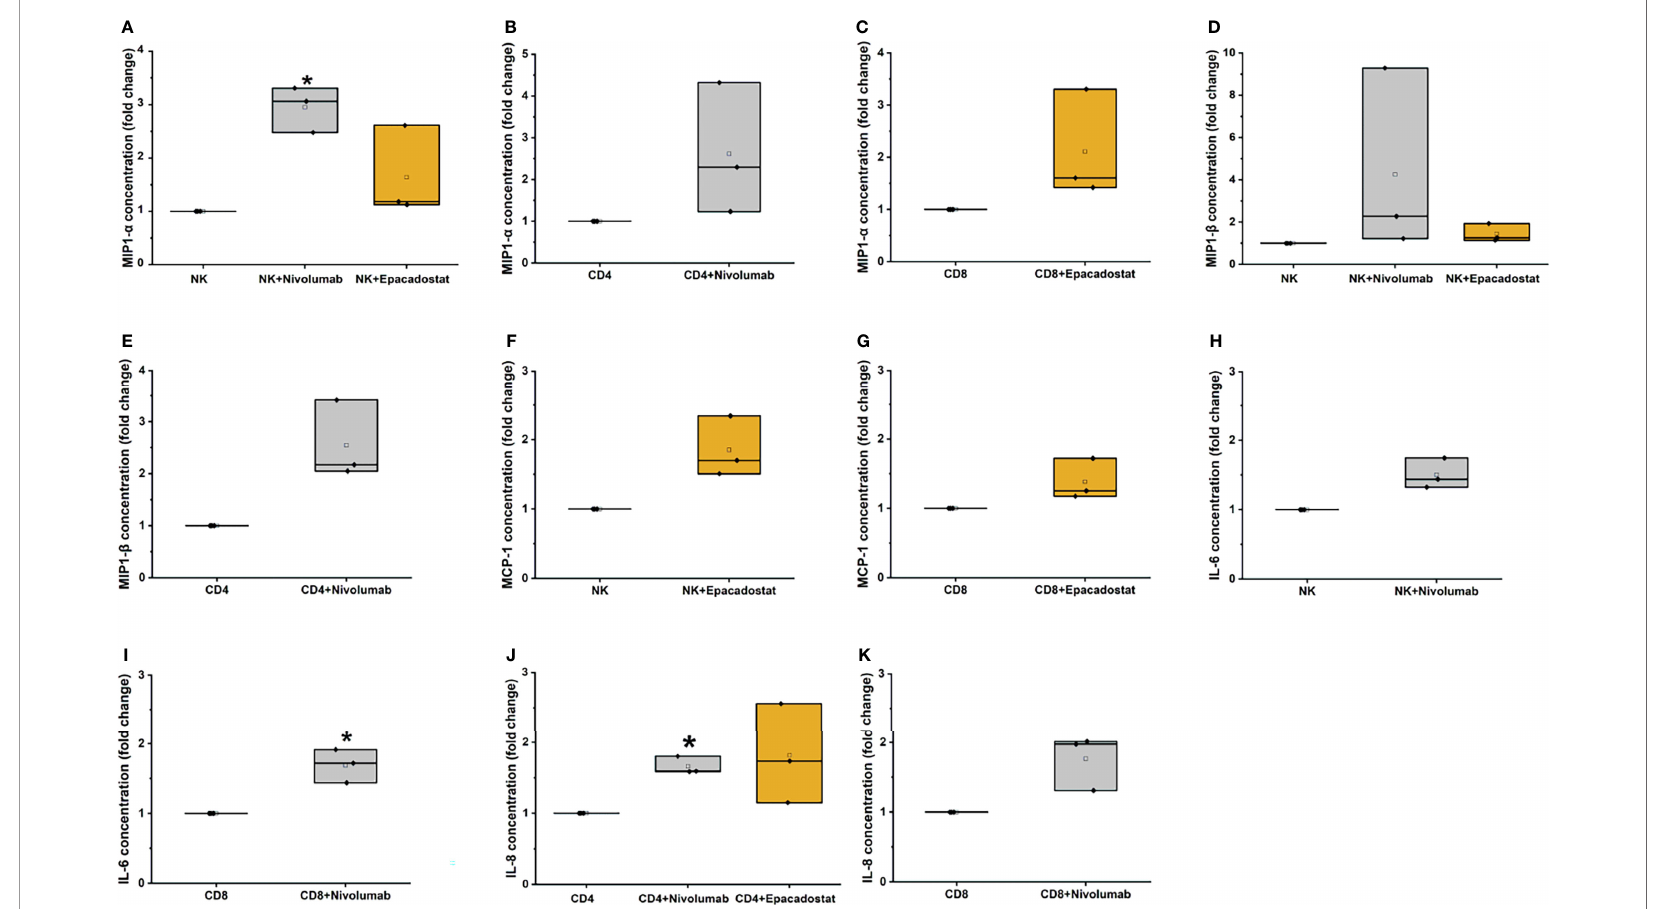
FIGURE 6 | Cytokine analysis results for MIP-1 a , MIP-1 b , MCP-1, IL-6, and IL-8. MIP-1 a levels increased signi fi cantly for NK cells with nivolumab treatment ( A , *p=0.01). The CD4 + (B) and CD8 + T cells (C) showed a similar trend of increase with nivolumab and epacadostat treatment, respectively. MIP-1 b levels exhibited an increasing trend for NK cells with nivolumab and epacadostat treatment (D) . CD4 + T cells had similarly elevated MIP-1 b levels with nivolumab treatment (E) . MCP-1 levels were increased by CD8 + T (F) and NK cells (G) with epacadostat treatment. NK cells with nivolumab treatment exhibited an increasing trend in IL-6 levels (H) , while CD8 + T cells signi fi cantly elevated its levels ( I , *p=0.038). IL-8 levels were signi fi cantly elevated for CD4 + T cells with nivolumab treatment (*p=0.011); epacadostat treatment also